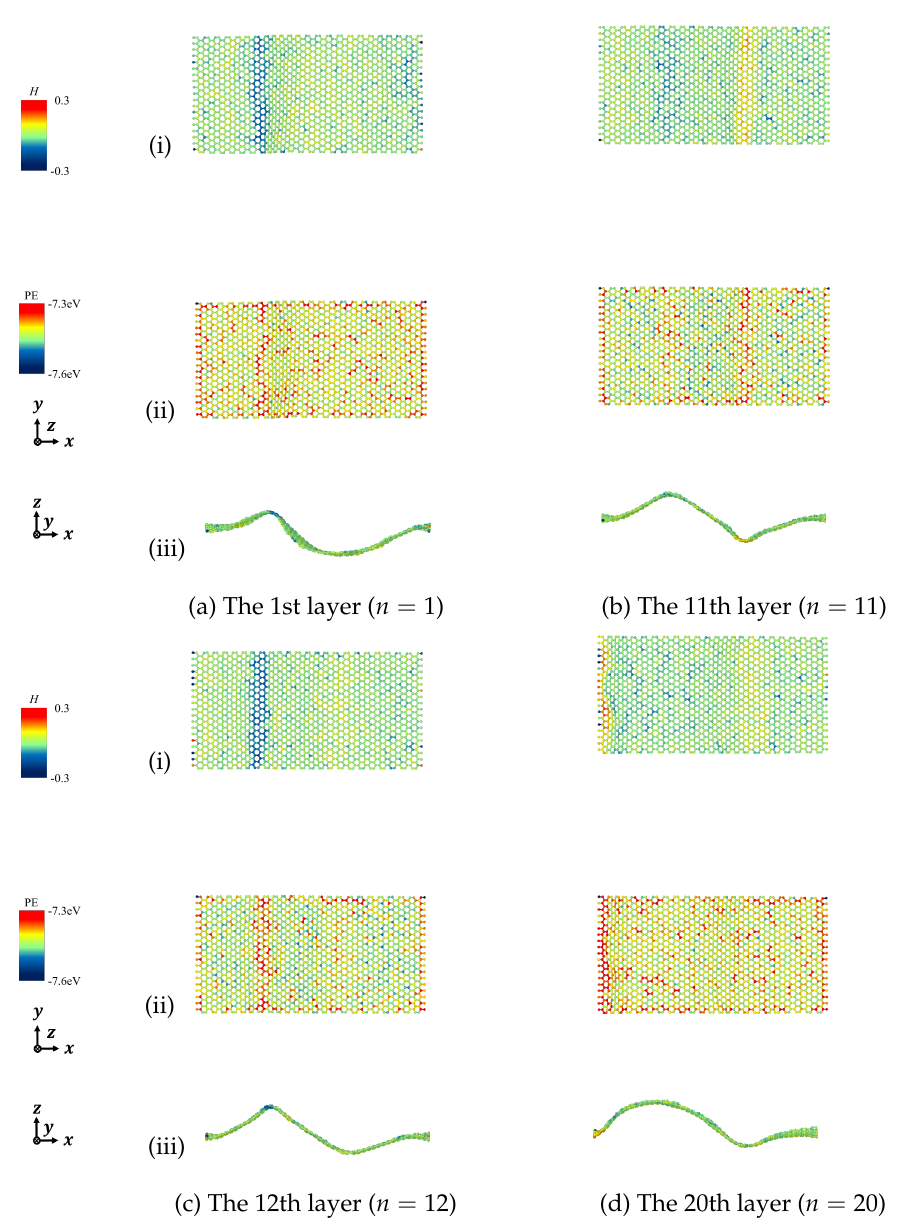
Figure 11. Mean curvature and site potential energy of curved surface of armchair graphite under compression ε = 0.10. (i) Site mean curvature, (ii) Site potential energy, and (iii) Mean curvature with deformation.